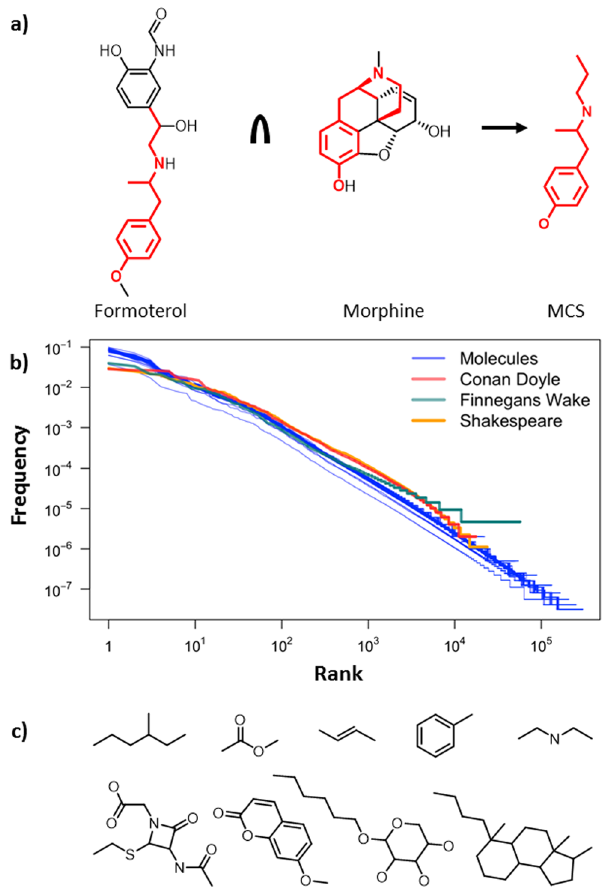
Figure 1. Chemical words and vocabularies. ( a ) Illustration of a common maximal substructure, MCS (colored red), between two molecules, formoterol (an anti-asthmatic/COPD drug) and morphine. ( b ) Blue lines are statistics of distinct MCS “words” for the entire 1.75-million-rich chemical vocabulary and over 100 randomly chosen subsets of Reaxys molecules (each subset with 500 to 9,000 molecules and 124,750–40,495,500 word tokens). The red, green, and orange lines are the distributions of words in, respectively, Conan Doyle’s collected works, Joyce’s “Finnegans Wake” novel, and Shakespeare’s works. All dependencies are rescaled by the number of words/molecules in a given set. As seen, the distributions for all sets are similar. ( c ) Examples of chemical words – those in the upper row are popular but not very specific fragments. Those in the lower row are less popular but immediately signal a specific group of chemicals (from left to right 1 st = penicillins and cephalosporins, 2 nd = coumarins, 3 rd = carbohydrates, 4 th = steroids). Note that the structures shown are molecular fragments not actual molecules with correct valences (e.g., if oxygen is monovalent, it can be attached to H, alkyl, aryl,